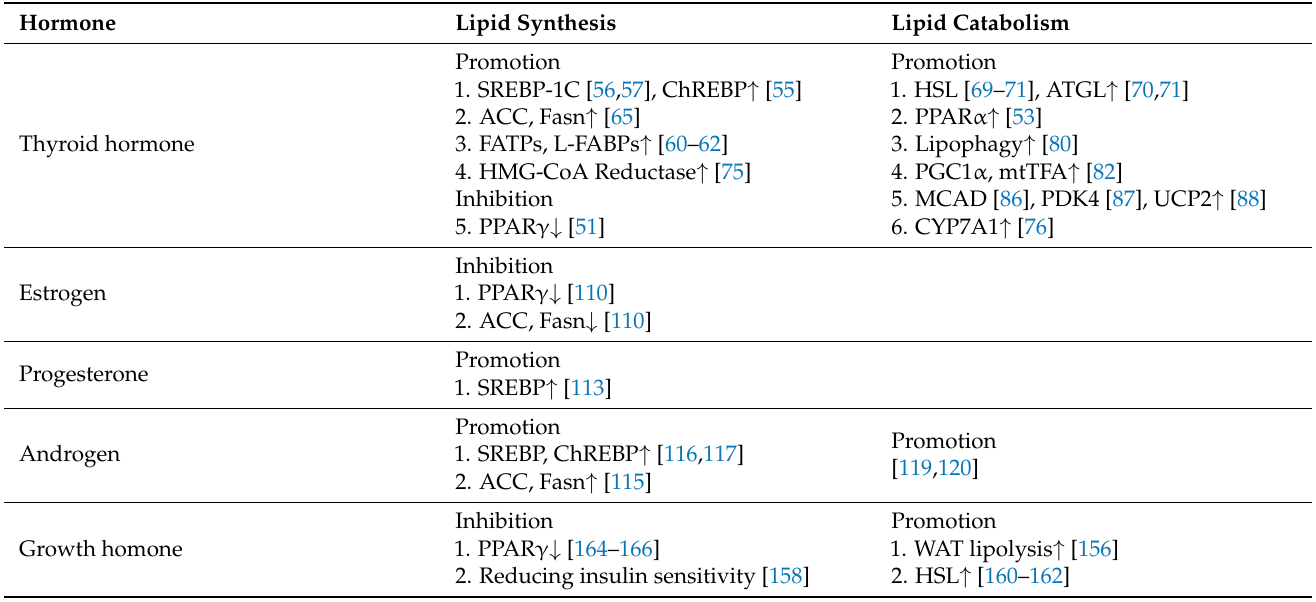
Table 1. Cont. Lipid Synthesis Lipid